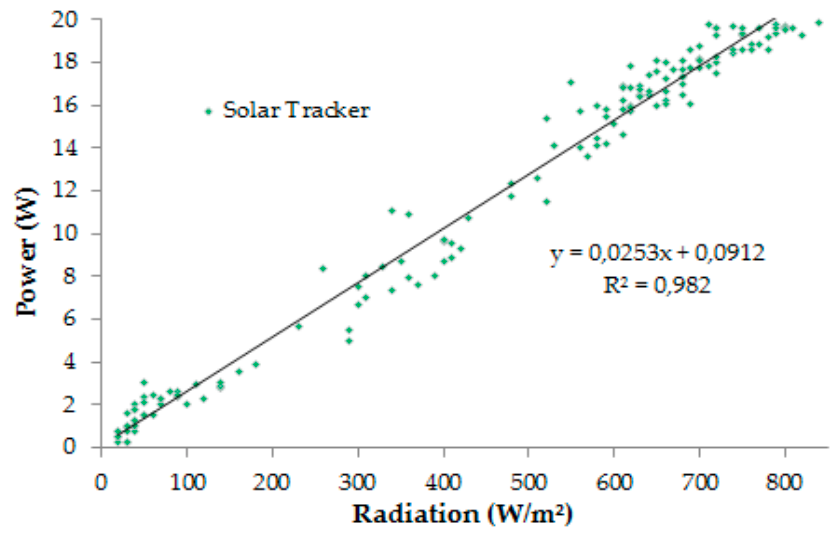
Figure 12. Correlation between produced power and incident radiation.